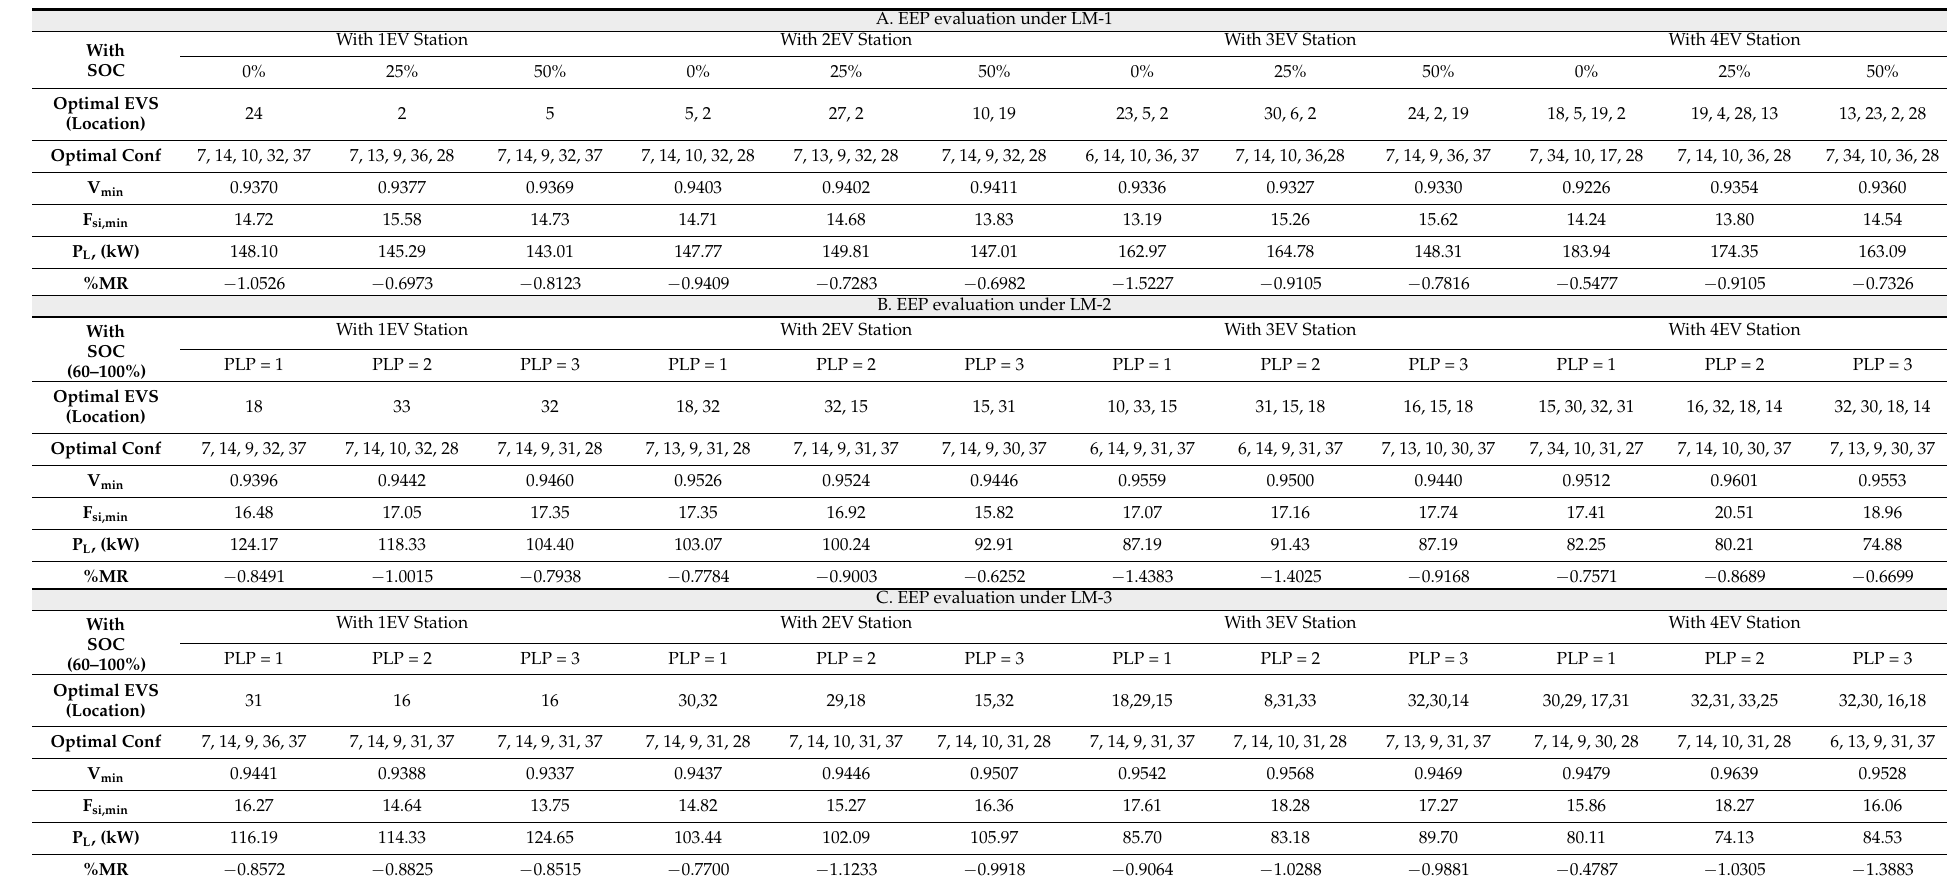
Table 7. EEP for Case-2 (when ESS works as a